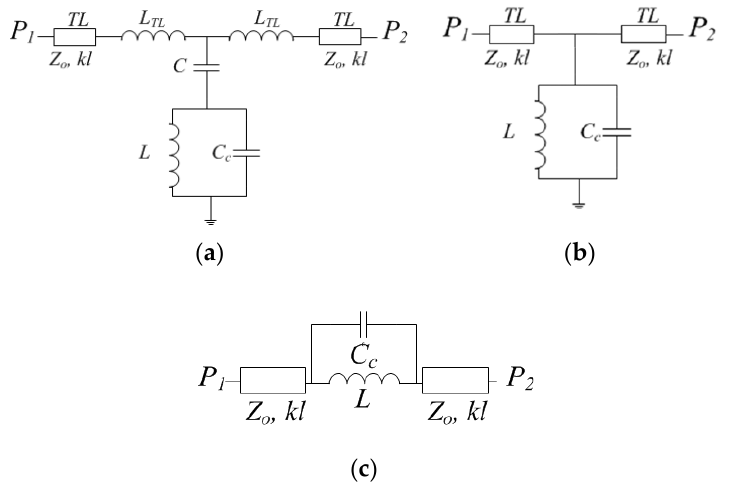
Figure 4. Circuit models of the CSRR- ( a ), OCSRR- ( b ), and DB-DGS-loaded line ( c ).